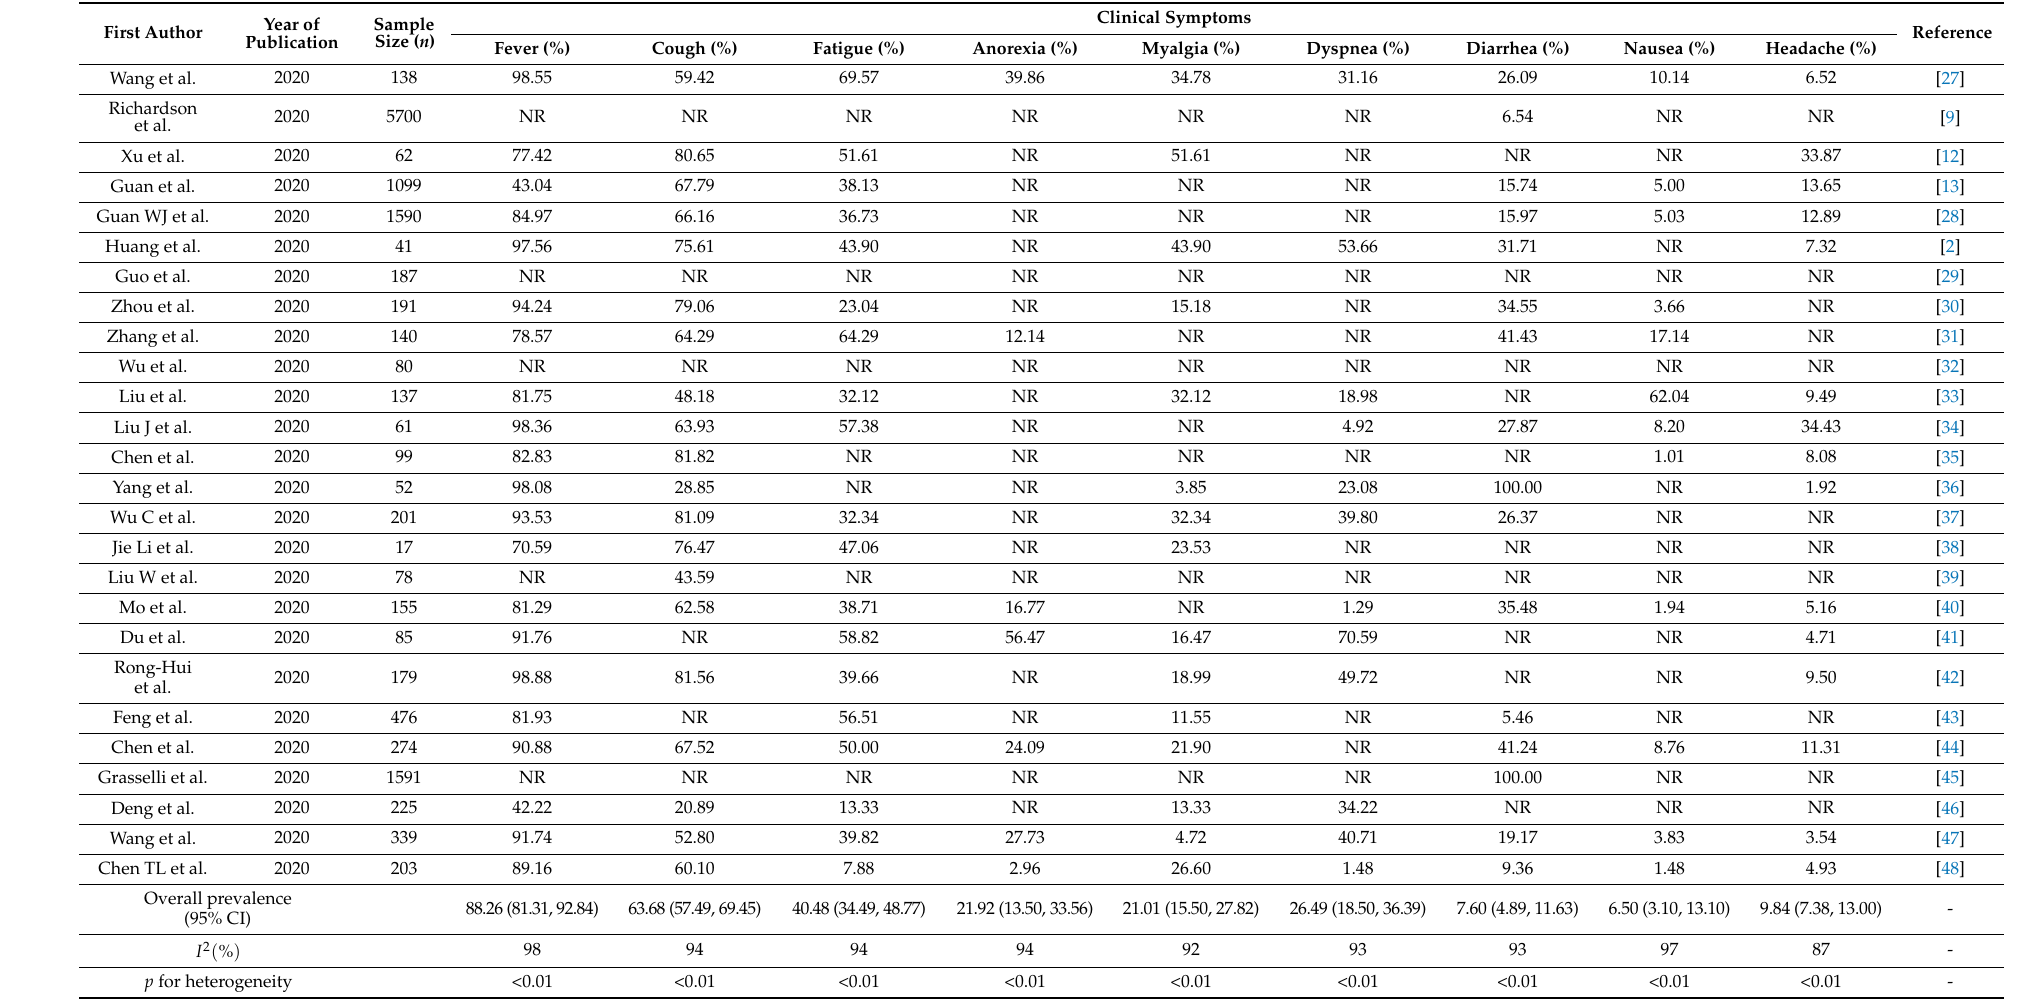
Table 2. Prevalence of symptoms in COVID-19 patients in the selected